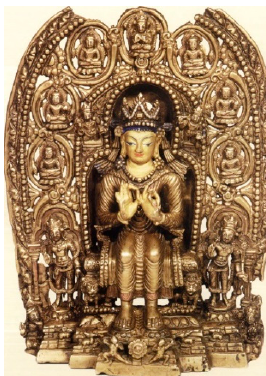
Figure 11. Buddha wearing a crown performing the dharmacakra-pravartana mudr ā . Approx. 675–722 C.E. Gilgit or Kashmir. Brass with copper and silver alloy. 31.1 cm H. Jo khang/gTsug lag khang Collection: inventory no. 261[A]. Lhasa, Tibet. https://www.himalayanart.org/items/57104. Copyright@